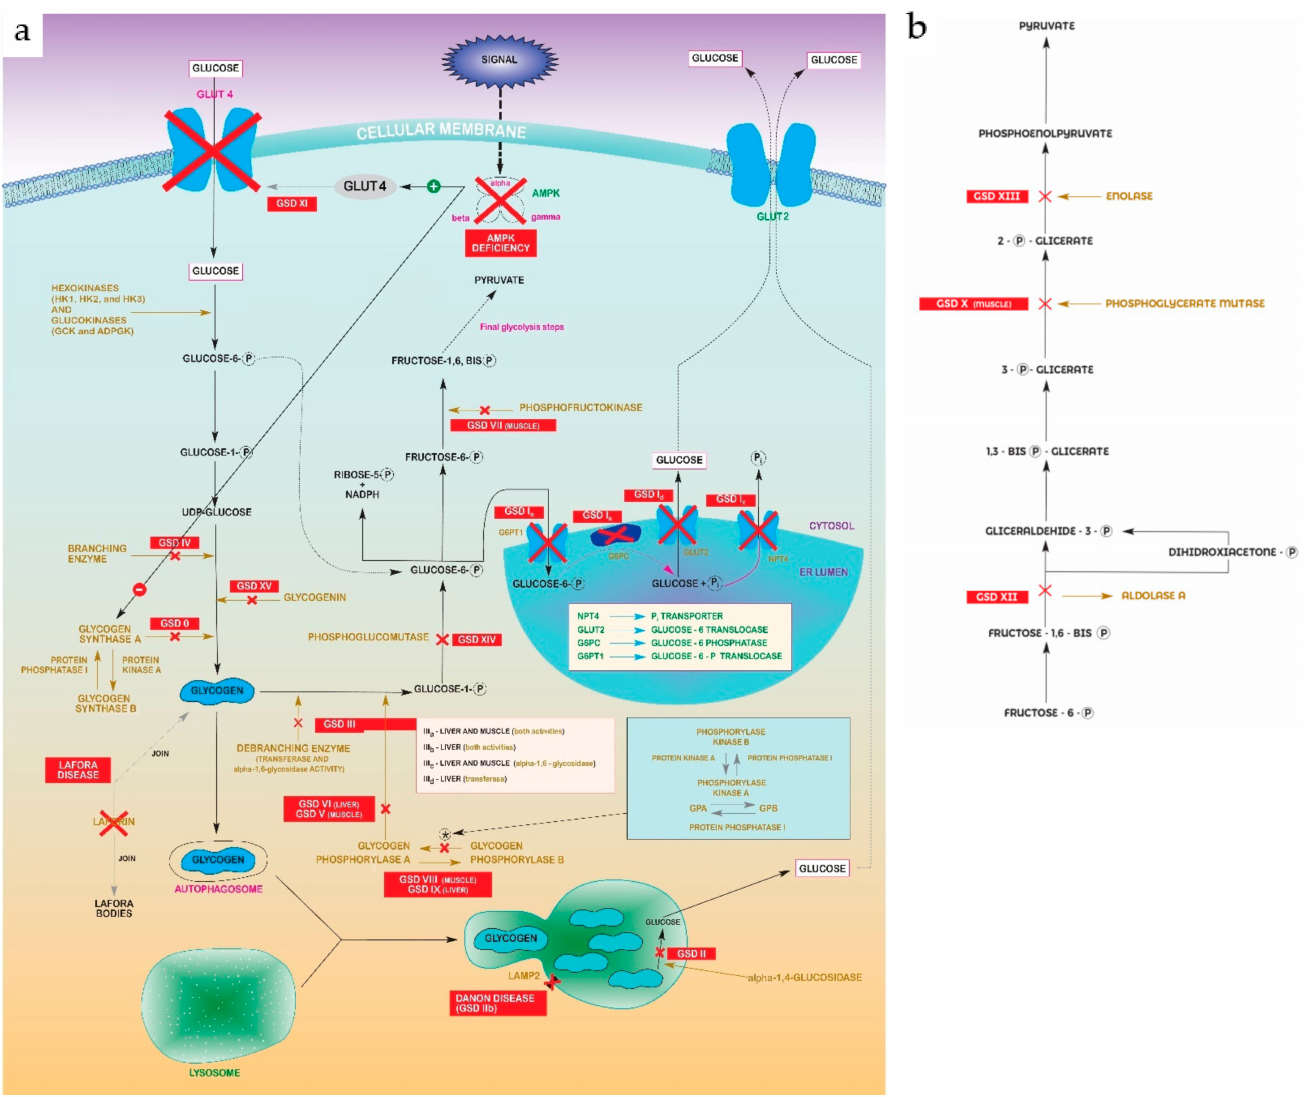
Figure 1. ( a ) Glycolysis–gluconeogenesis pathway showing steps disrupted in every GSD. Abbreviations: Glycogen Synthase Deficiency (GSD 0); Von Gierke Disease (GSD Ia, Ib, Ic, Id); Pompe disease (GSD II); Cori-Forbes Disease (GSD III); Andersen Disease (GSD IV); McArdle Disease (GSD V); Hers Disease (GSD VI); Phosphofructokinase Deficiency (GSD VII); Muscle Phosphorylase b Kinase Deficiency (GSD VIII); Liver Phosphorylase Kinase Deficiency (GSD IX); Fanconi-Bickel Syndrome (GSD XI); Phosphoglucomutase 1 Deficiency (GSD XIV); Glycogenin Deficiency (XV). ( b ) “Zoomed in” detail of pyruvate formation in final glycolysis steps from Figure 1a. Abbreviations: Muscle Phosphoglycerate Mutase Deficiency (GSDX); Aldolase A Deficiency (GSDXII); Enolase 3 Deficiency